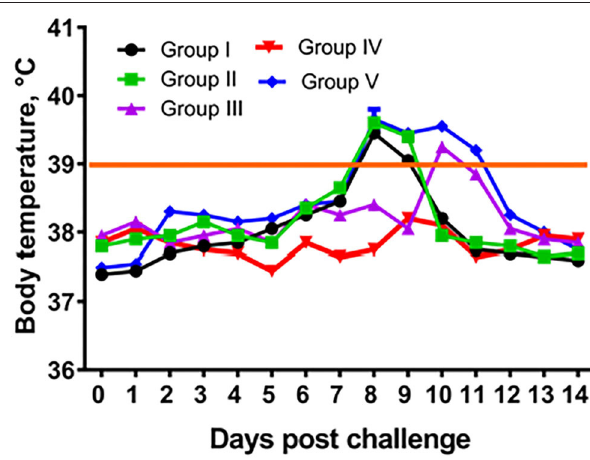
FIGURE 4 | Temperature response of vaccinated camels after challenge with virulent wild-type virus. Group I – camels vaccinated using a dose 10 1.0 EID 50 /0.2mL; Group II – camels vaccinated using a dose 10 2.0 EID 50 /0.2mL; Group III – camels vaccinated using a dose 10 3.0 EID 50 /0.2mL; Group IV – camels vaccinated using a dose 10 4.0 EID 50 /0.2mL; Group I – control camels administered with